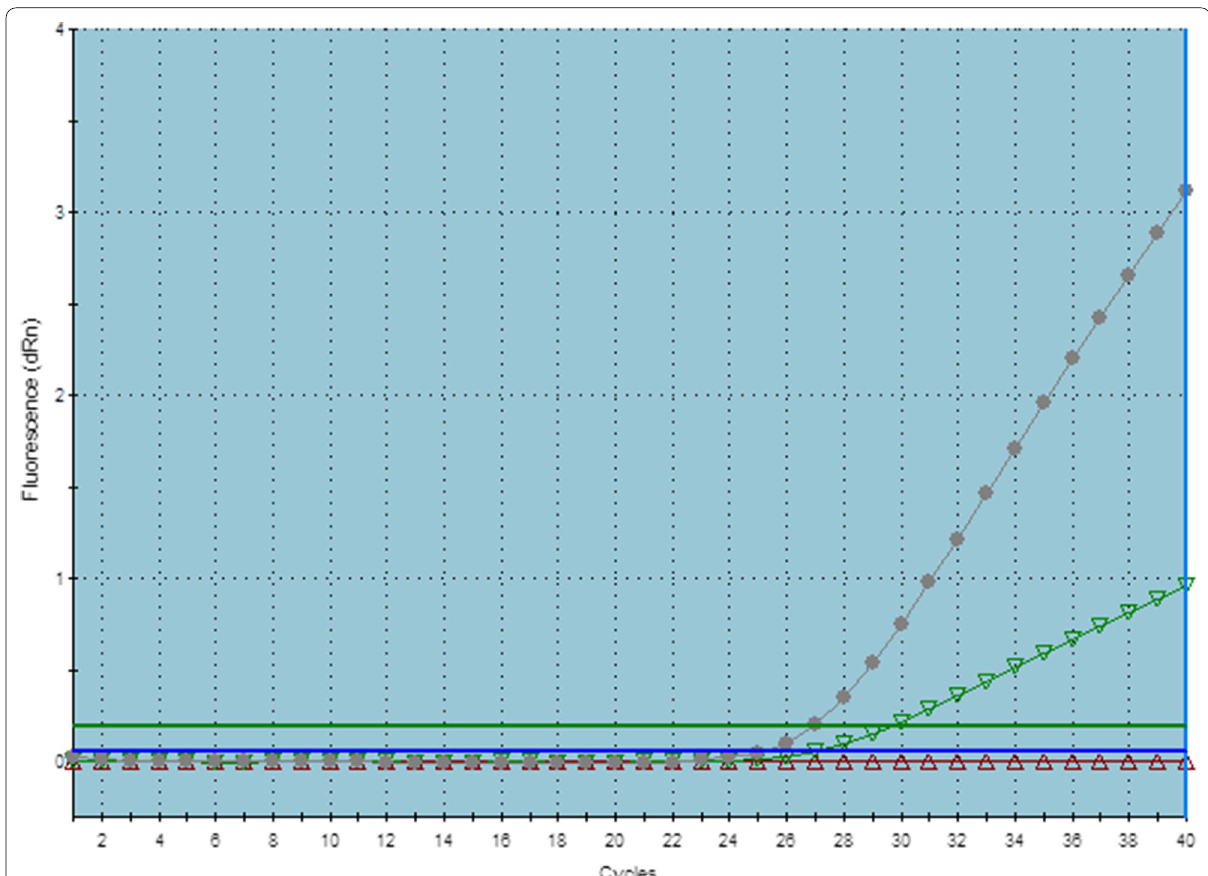
Fig. 1 Amplification plot curve showing a case with AT heterozygous genotype for DVWA gene SNP ( rs11718863 ). It shows amplification of both A allele and T allele. A allele is represented as circles and T allele is represented as